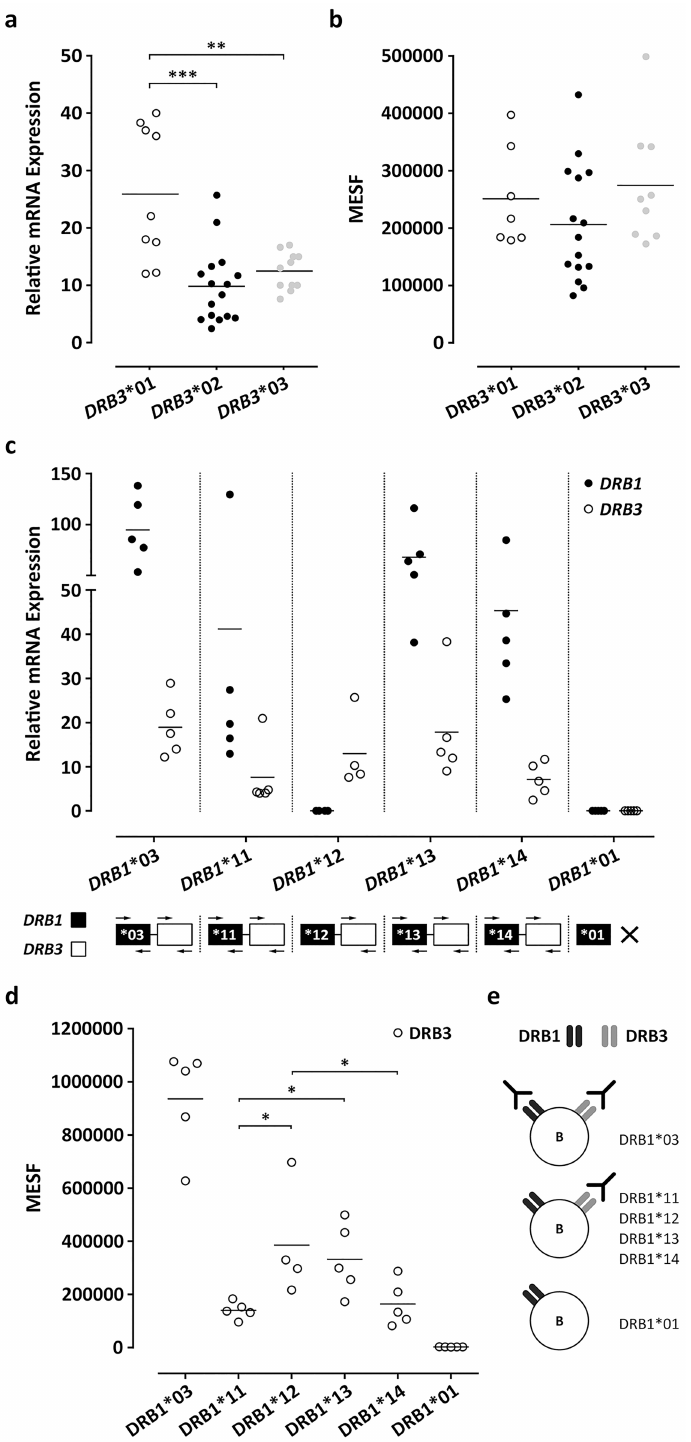
Fig 4. The relative mRNA and protein expression of HLA-DRB1 and HLA-DRB3. a. The relative mRNA expression of HLA-DRB3 (cid:3) 01 ( n = 9), (cid:3) 02 ( n = 16), and (cid:3) 03 ( n = 11) in isolated B cells from deceased donors. The relative mRNA expression was determined by quantitative PCR (Q-PCR) and the values were normalized to reference gene HuPo . b. The cell surface expression of HLA-DRB3 (cid:3) 01 ( n = 7), (cid:3) 02 ( n = 15), and (cid:3) 03 ( n = 9) on B cells. Splenocytes from the donors were incubated with monoclonal 7.3.19.1 antibody, which binds to the specific epitope 77N that is present